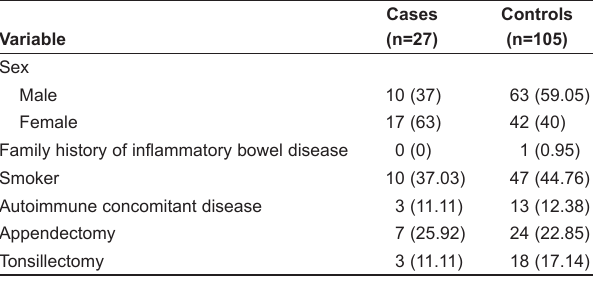
Table 2 Clinical characteristics of Crohn disease (CD)